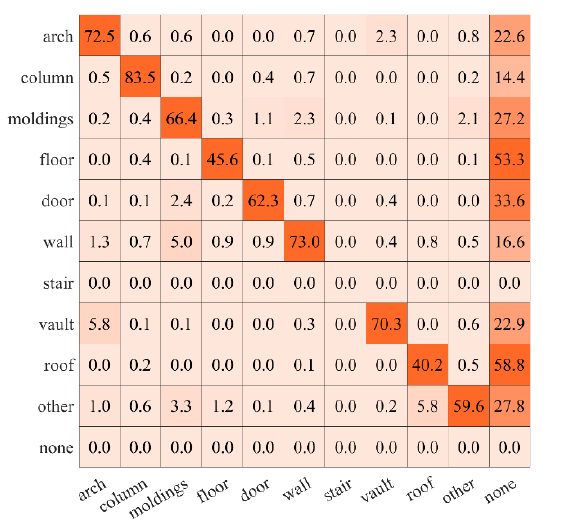
Figure 7 . Confusion Matrix for 2_OSA back-projection. 3_SSA Basilica della Santissima Annunziata